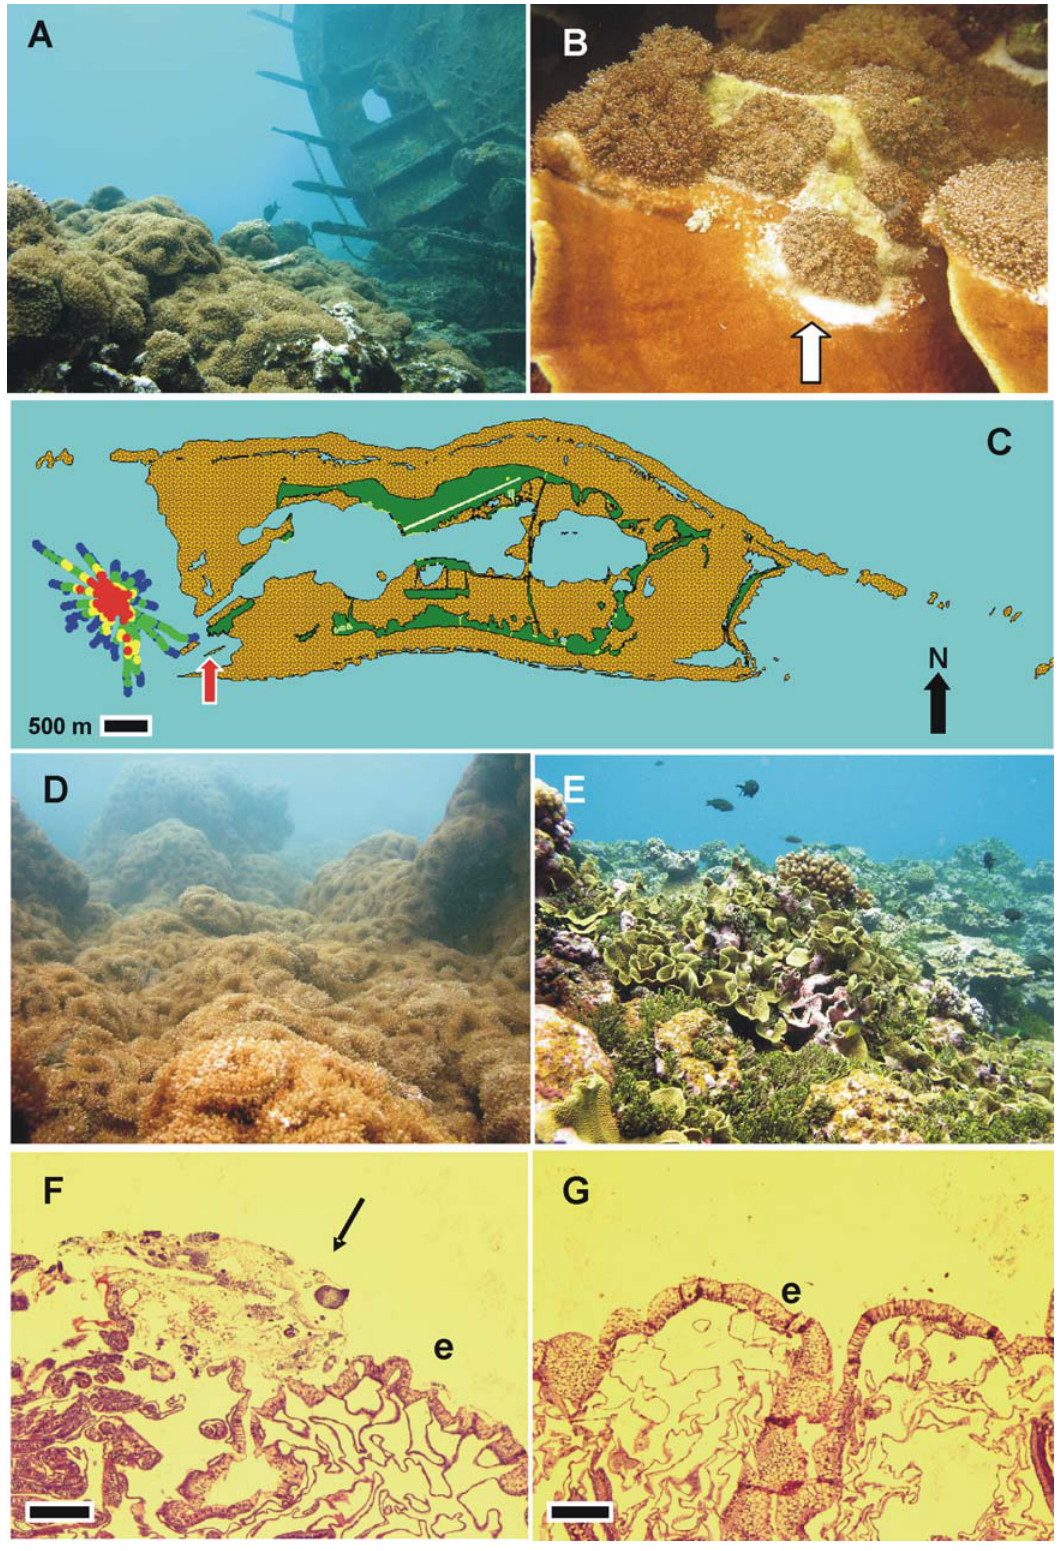
Figure 1. Invasion of the western shelf of Palmyra by corallimorphs from macro to micro scale. A) Shipwreck (right) and monoculture of R. howesii (left). B) Close up of Montipora capitata overgrown with R. howesii , note acute tissue loss where corallimorph has retracted (arrow). C) Extent of corallimorph infestation on western shelf of Palmyra Atoll NWR. Color codes dots correspond to estimated benthic cover of corallimorphs: red=high ( . 60%), yellow=medium ( . 30–60%), green=light (1–30%), blue=no visible corallimorphs. The ship is at the center of the red zone. Red arrow points to area where buoys were surveyed (Penguin Spit). The dark green area on the map represents emergent land with air strip (yellow line), and the brown area is submerged plateau surrounded by reef crest. D) Monoculture of R. howseii near ship. E) Unaffected reef. F) Photomicrograph of Acropora sp. with R. howesii -induced tissue loss manifesting tissue fragmentation and necrosis (arrow); e-epidermis, bar=200 m m. G) Photomicrograph of normal Acropora sp.; e-epidermis, bar=200 m m. doi:10.1371/journal.pone.0002989.g001 PLoS ONE | www.plosone.org